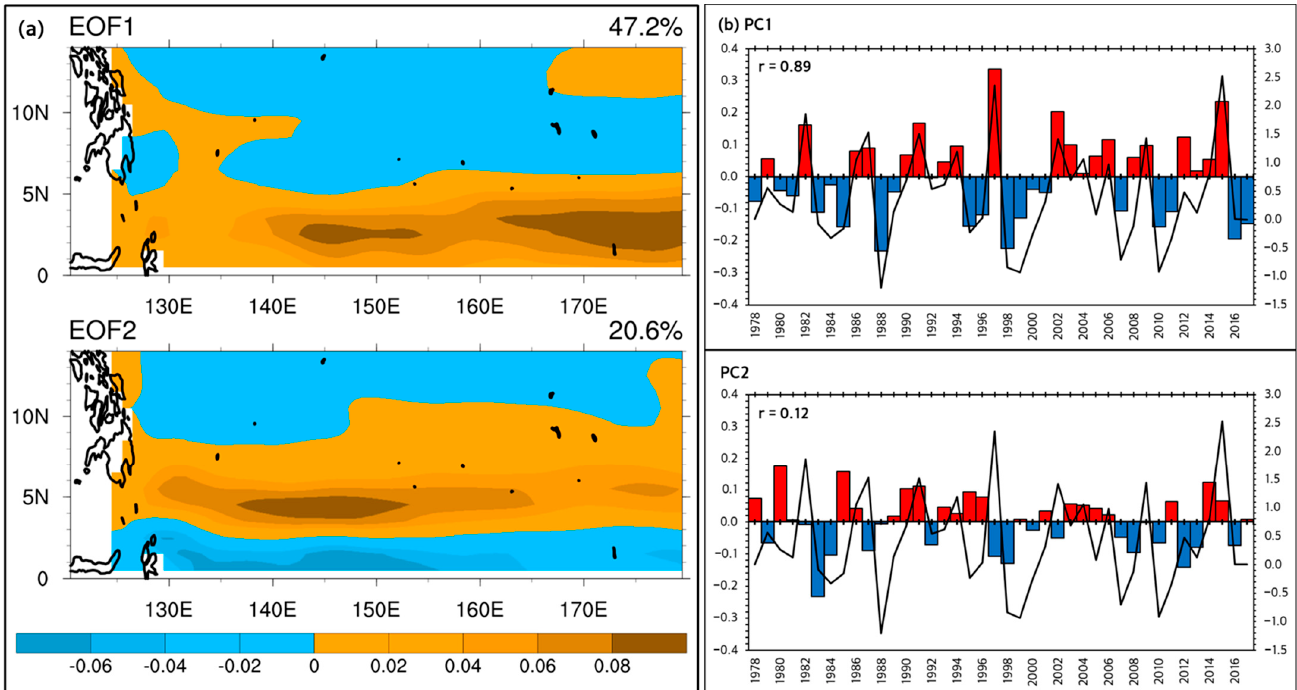
Figure 6. The first and second EOF modes of boreal autumn (SON) zonal current geographical distribution ( a ), and associated time series PC from 1978 to 2017 overlaid with the NIÑO 3.4 indices (black line) ( b ). In ( b ), the positive and negative values denote the greater and weaker NECC magnitudes, respectively.